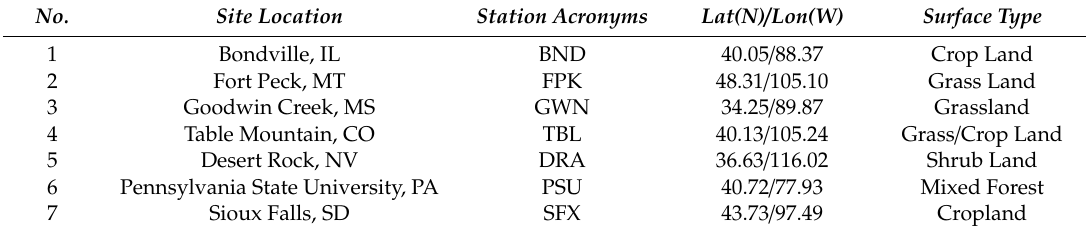
Table 6. Geolocation and surface type of the seven Surface Radiation budget (SURFRAD) stations.